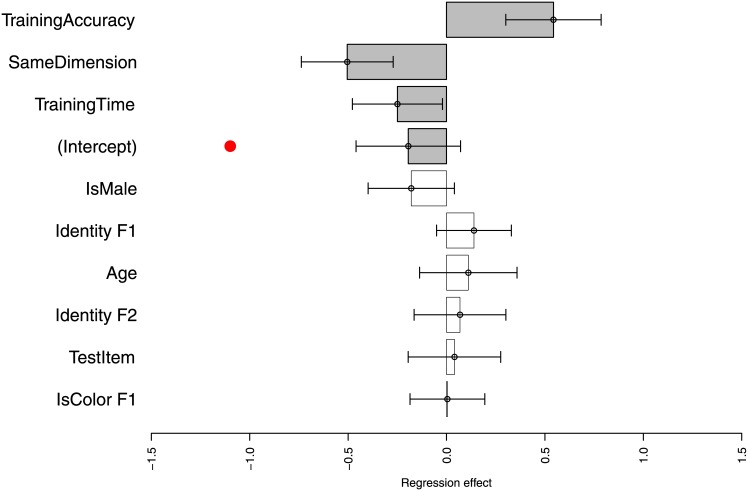
Coefficients in a mixed-effect logistic regression predicting accuracy on test (two-screen) trials from a number of predictors.There intercept here, representing the mean accuracy, should be compared to the chance rate of 1/4 (red dot, at logit(0.25) on this scale), the overall chance guessing rate for 4 options. All other coefficients should be compared to the x = 0 line, showing whether they had a statistically significant influence on response accuracy. Effects significant at p < 0.05) are shown with gray bars.